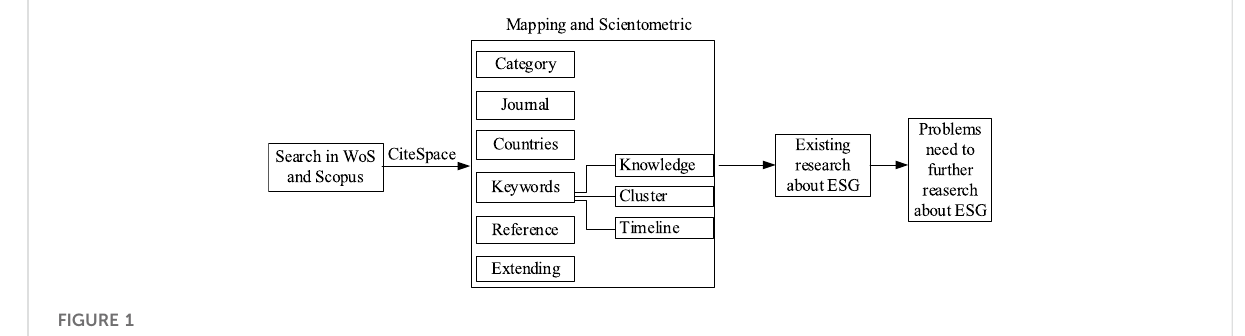
FIGURE 1 Description of the four-step process.